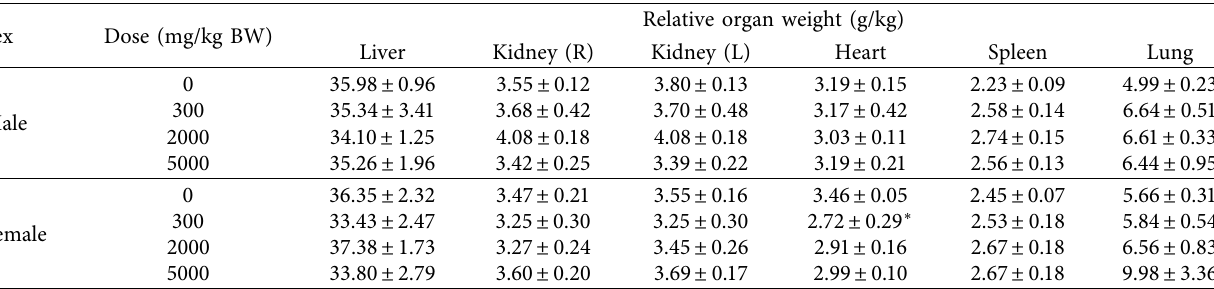
Table 6: Relative organ weight of experimental animals after 14 days of single oral administration of different doses of EEAC from acute toxicity study.